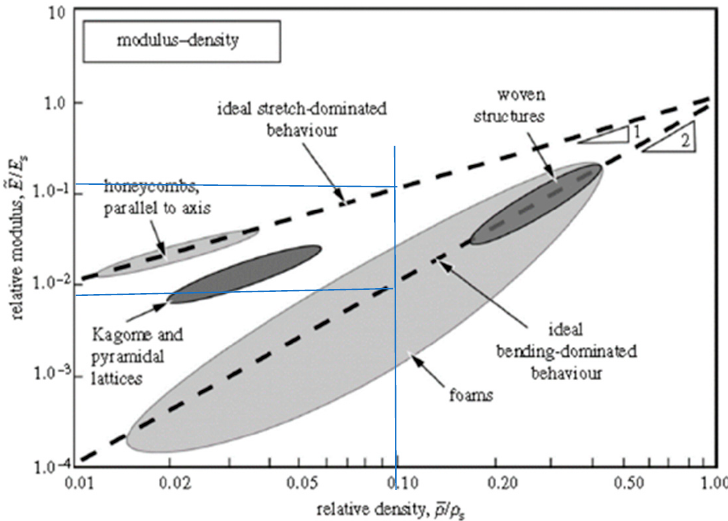
Figure 2 . Plot of relative density and relative (Young’s) modulus for stretch- and bend dominated structures, compared with results from mechanical testing of various cellular materials [2] .